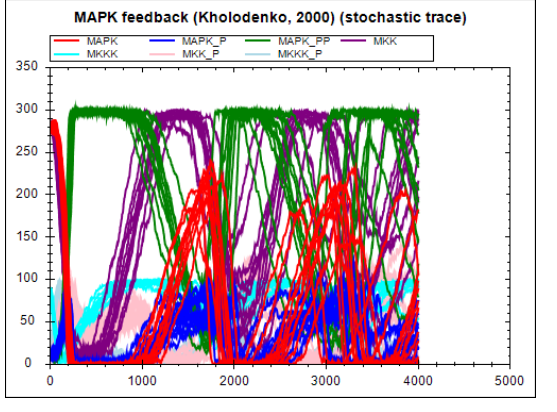
Figure A.7: The simulation result from the simulation description given in List- ing A.5. Simulation with SED-ML web tools [2].